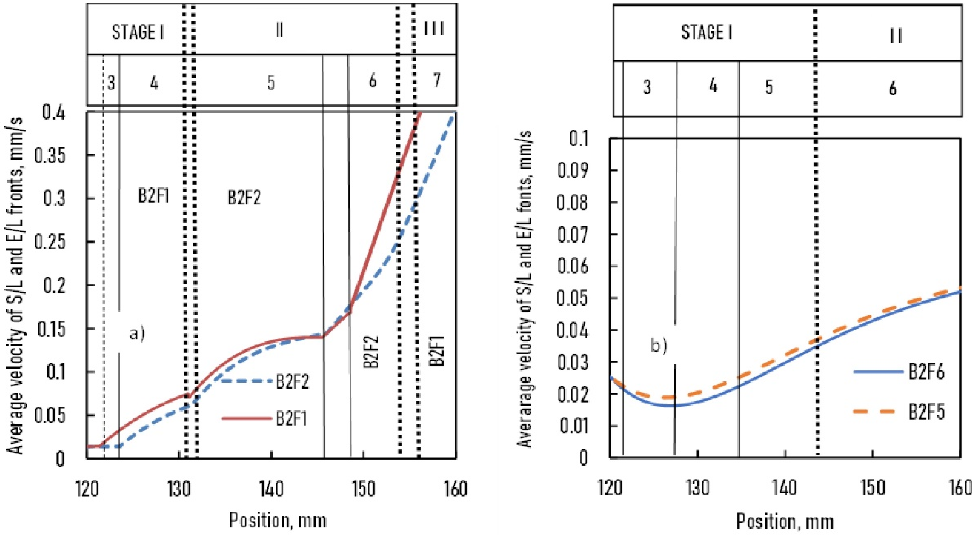
Figure 9. Average velocity of S/L and E/L fronts vs. position in the sample ( a ): samples B2F1 and BF2, ( b ): samples B2F5 and B2F6.